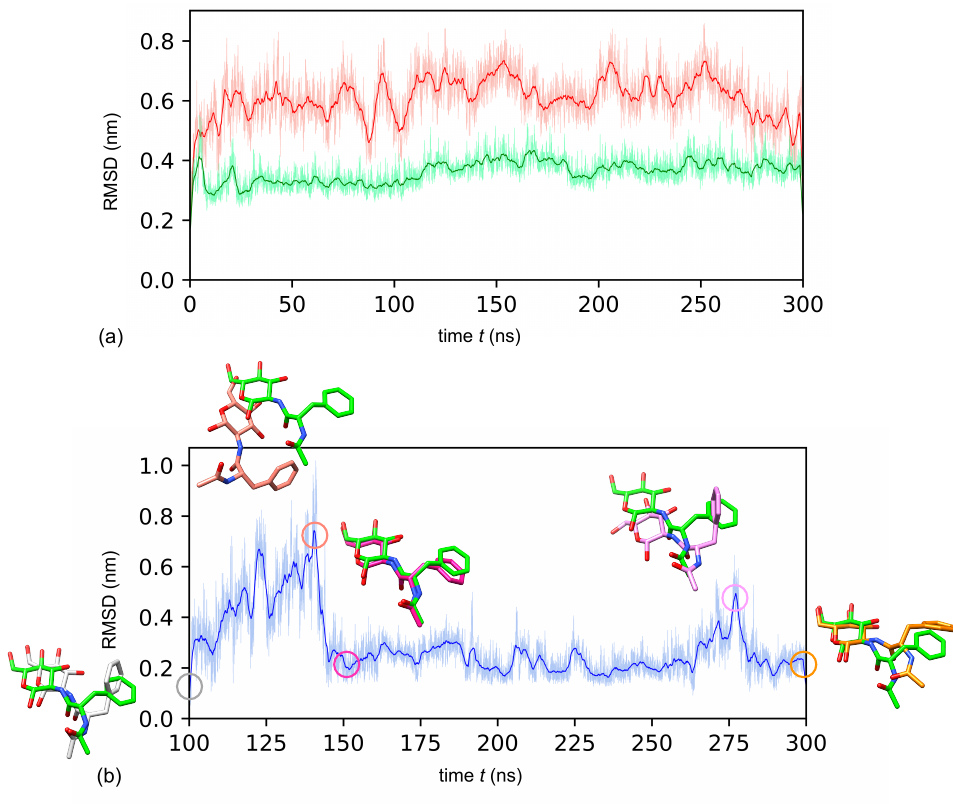
Figure 6. RMSD trajectory of IKK α and NAPA. ( a ) IKK α presents higher backbone RMSD values in the NAPA-unbound form (6.1 ± 0.8 Å) compared with the NAPA-bound form (red line) (IKK α -NAPA complex), (green line) (3.6 ± 0.4 Å). ( b ) RMSD of the ligand heavy atoms evolution of the NAPA molecule alone (2.38 ± 0.65 Å). Bold lines represents running averages, while light lines indicates individual time steps spaced 10 ps apart. Overlay of the representative NAPA pose selected from the MD trajectory (reported in green) with important intermediates along the trajectory are depicted in stick representation (see the main text for further details). Overlay of the initial and final poses from the MD simulation is reported in Figure